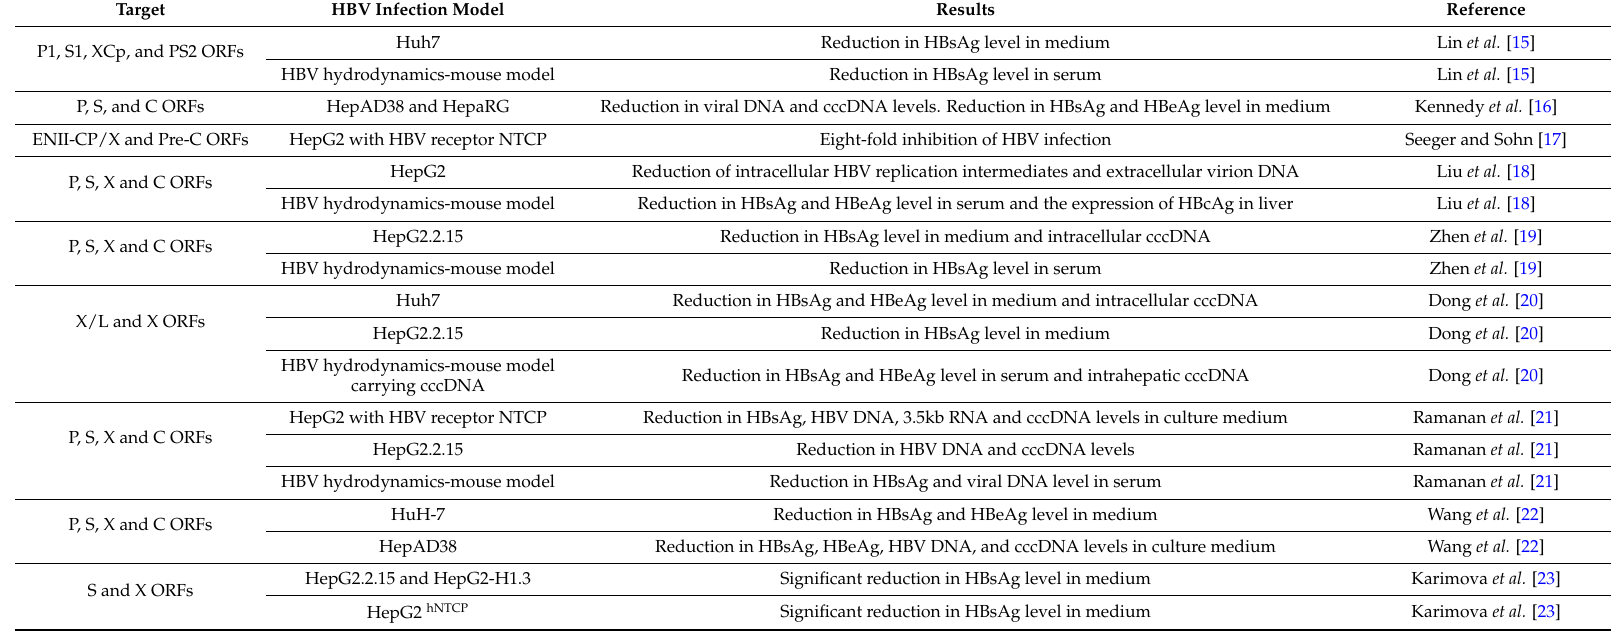
Table 1. Application of CRISPR/Cas9 to